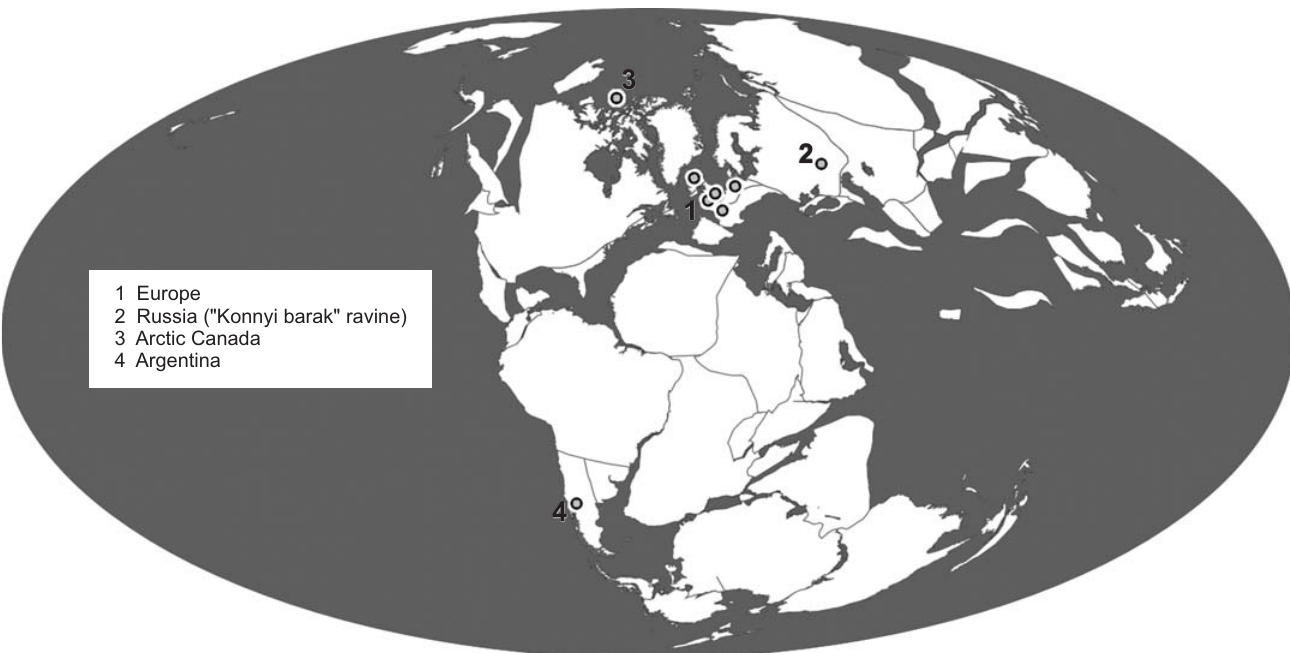
Fig. 10. Callovian palaeogeographic map (constructed by https://paleobiodb.org using plate rotations based on Wright et al. 2013) showing plesiosaur localities discussed in the